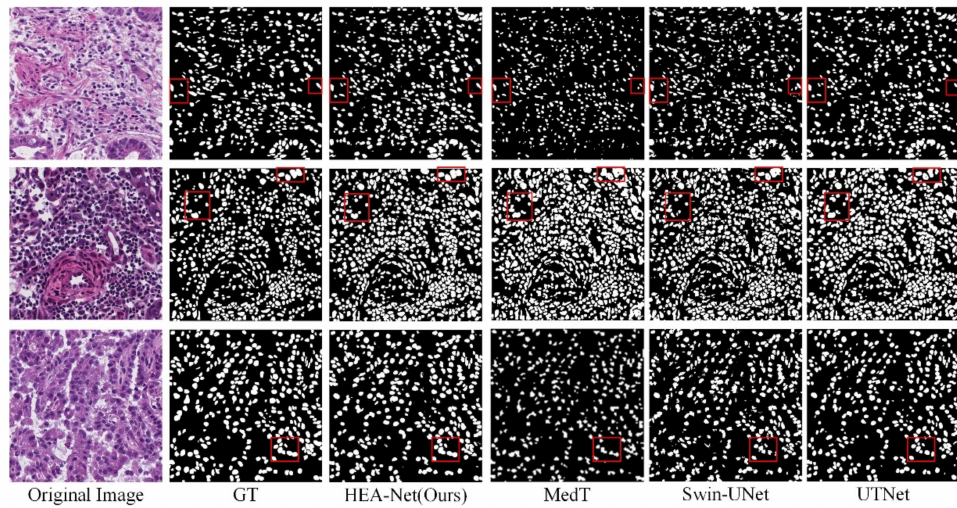
Figure 8. Qualitative results of MoNuSeg dataset based on Transformer. In the red box are the parts with significant differences in the segmentation results of each